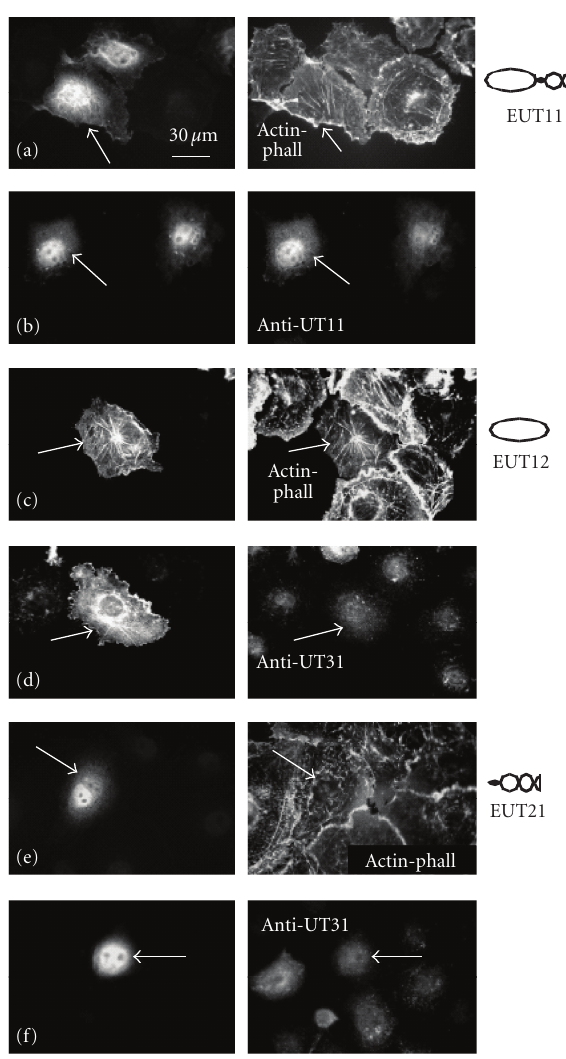
Figure 8: Intracellular sorting of utrophin fragments by expression of eukaryotic vectors in COS7 cells (EUT11, EUT12, and EUT21, all carrying the FLAG-tag at the C-terminus). Cells in the vertical row at the left are all stained with the anti-Flag M2 mAB ((a), (b), (c), (d), (e), (f)). Rhodamine-phalloidin staining for actin displays stress fibres and a dense cortical actin cytoskeleton along the cell membranes in the COS7 cells spreading on the substratum ((a), (c), (e) at the right). Anti-UT11 recognises full-length utrophin and N-utrophin giving intensive staining in and around the nucleus that results from the heterologously expressed EUT11 plus the endogenous utrophin ((b) at the right). Anti-UT31 (spectrin 14–16 in the rod) stains COS7 cells di ff usely throughout the cytoplasm without marking any defined actin structures ((d), (f) at the right). EUT21 (first two spectrin domains) exclusively concentrates in the nuclei ((e), (f)). EUT12 (actin-binding domain alone) precisely traces the actin microfilaments and the cortical cytoskeletal structures ((c), (d)). For further explanation see the